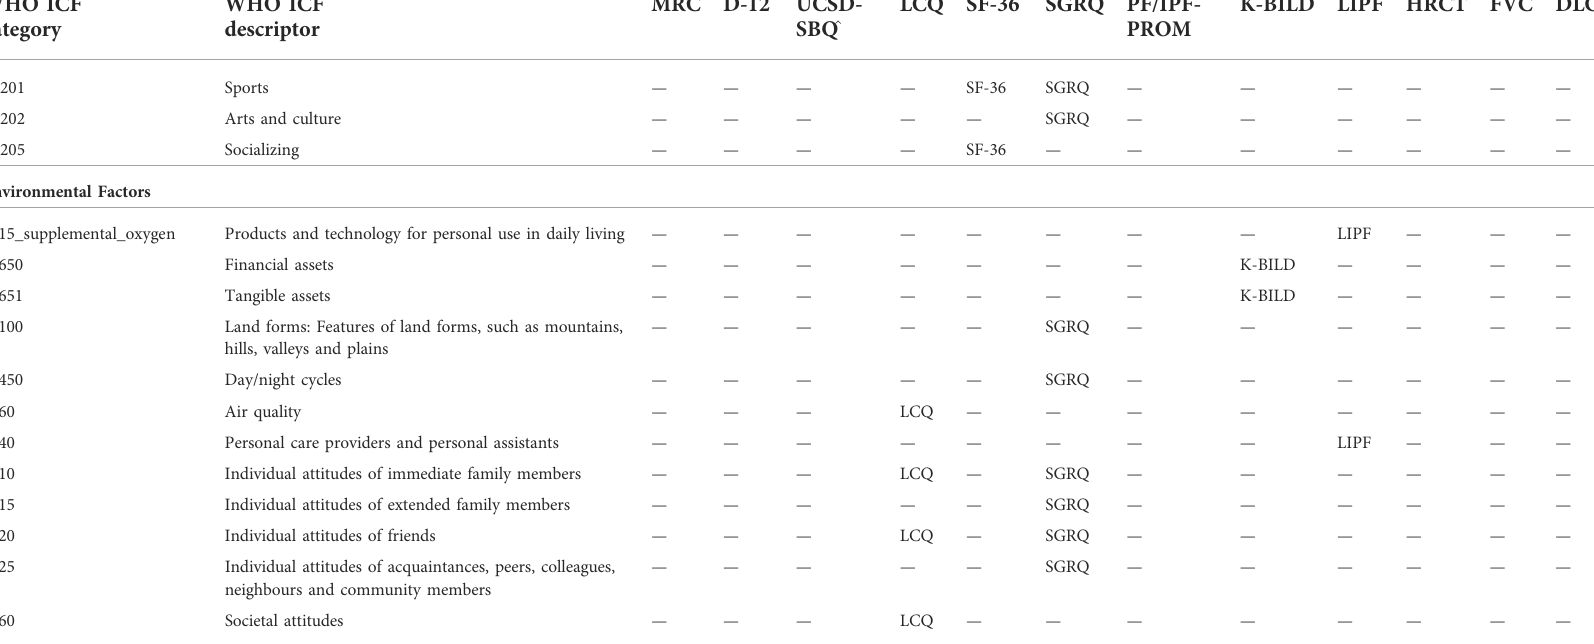
e460 Societal attitudes — — — LCQ — — — — — — — — MRC:medicalresearchcouncildyspneascale;D-12:Dyspnea-12,UCSD-SBQ:UniversityofCaliforniaShortnessofBreathQuestionnaire,LCQ:LeicesterCoughQuestionnaire,SF-36:IPF-PROM:PulmonaryFibrosis-Patient-ReportedOutcomeMeasure; K-BILD: King ’ s Brief ILD, questionnaire, LIPF: Living with IPF Questionnaire, Medical Outcomes Study Short-Form 36, VAS-PG: visual analogue scale patient global assessment of disease activity; HRCT: extent of interstitial disease on high resolution computed tomography; FVC: forced vital capacity; DLCO: diffusion capacity of lung for carbon monoxide. All instruments apply to both IPF, and CTD-ILD, unless where indicated. a Indicates an ICF, category with linkages to 3 or more instruments. ^ Indicates the consensus instrument was for IPF,